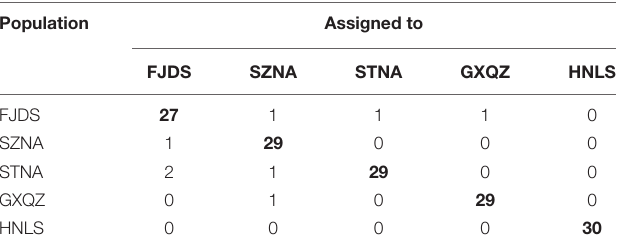
TABLE 5 | Results of assignment tests based on the Bayesian method for 10 microsatellite loci of C. nobilis individuals. Population Assigned to